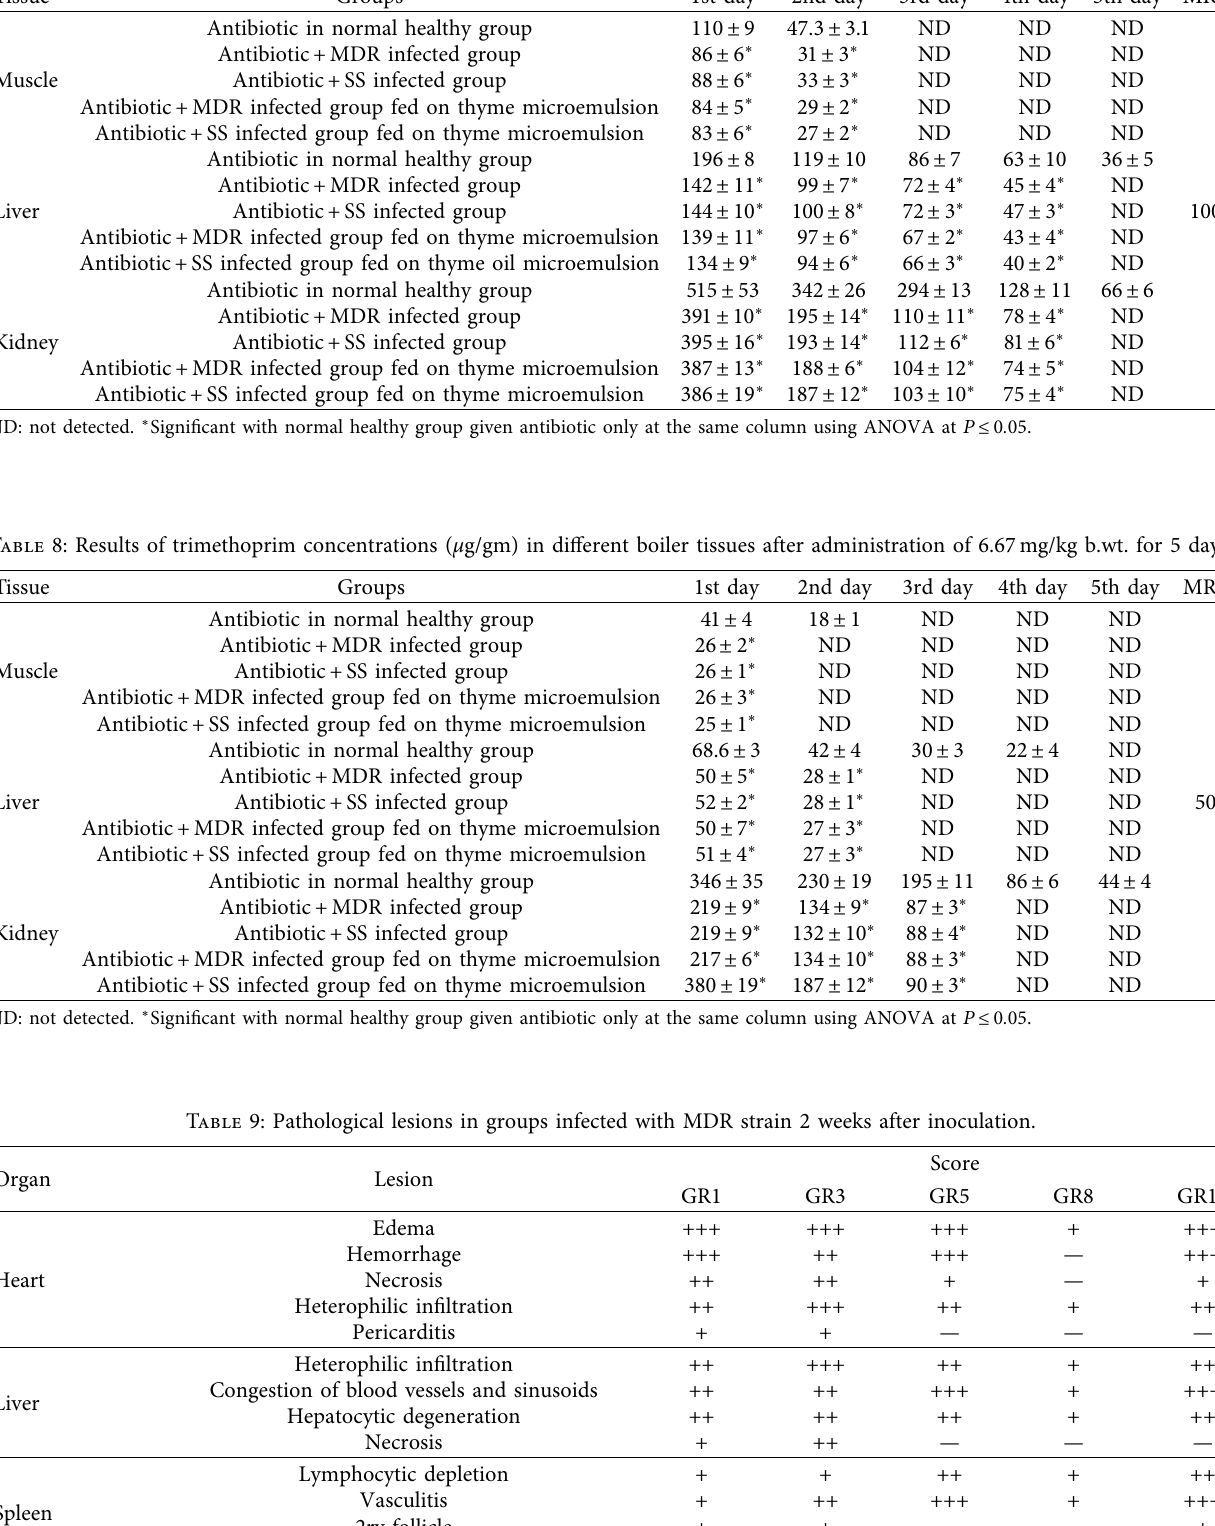
Table 7: Results of sulfadiazine concentrations ( μ g/gm) in different boiler tissues after administration of 33.34mg/kg b.wt. for 5 days. Tissue